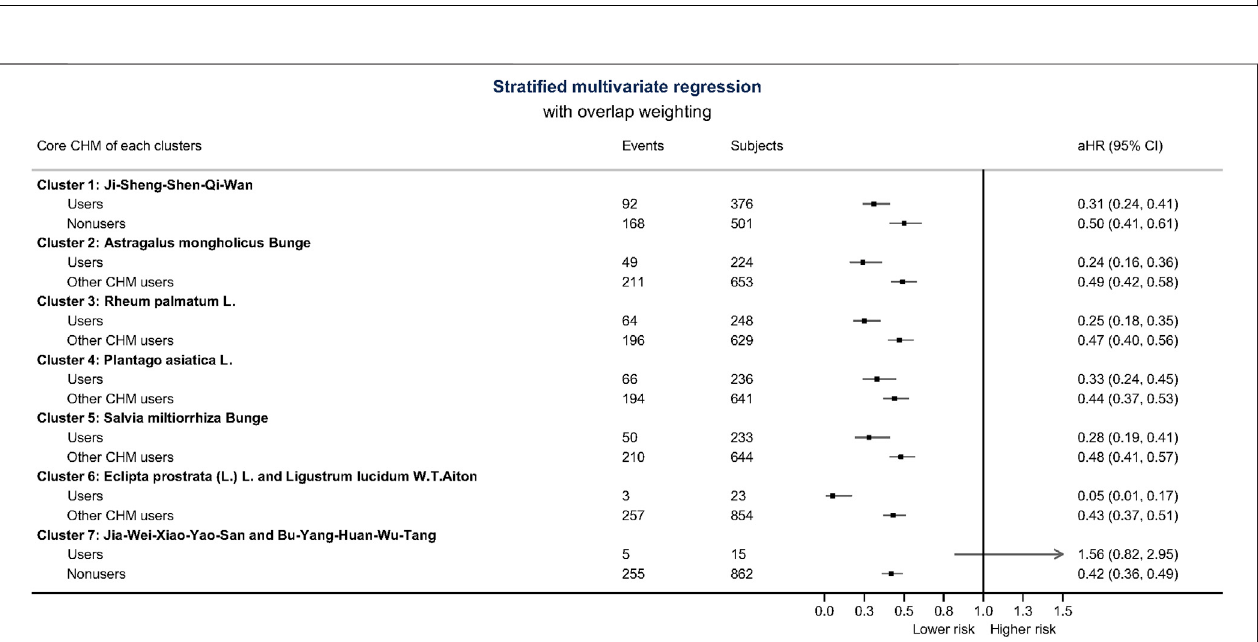
Frontiers in Pharmacology |